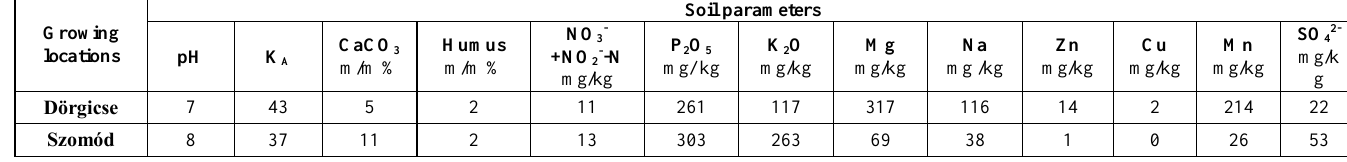
Table 1/b. Soil characteristics of the growing areas of Lavandula in Dörgicse and Szomód (According to soil analyses of the growers).